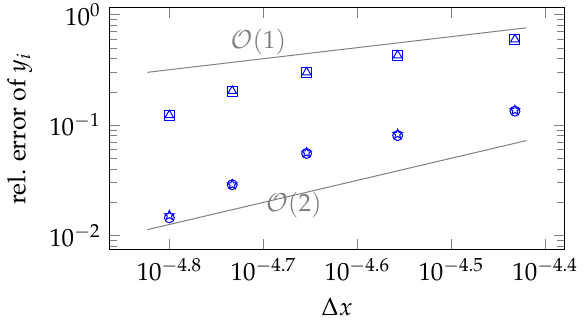
Figure 4. Grid independency study (simulations). Relative errors of y 1 = (cid:107) u ( x ,4 ) (cid:107) y 2 = (cid:107) ϕ ( x ,4 ) (cid:107) ( ), E ( ϕ ) ( ), σ 2 ( ϕ ) ( ) with regard to the finest resolved simulation. L 2 ( Γ out )